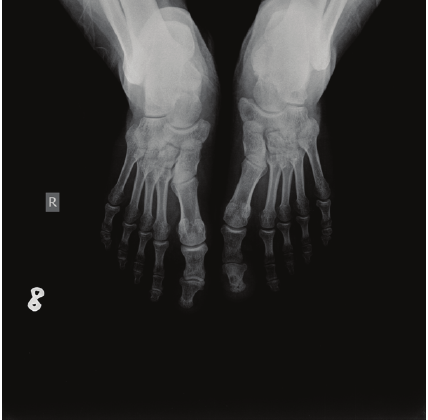
Figure 2: Preoperative AP X-ray of both feet.